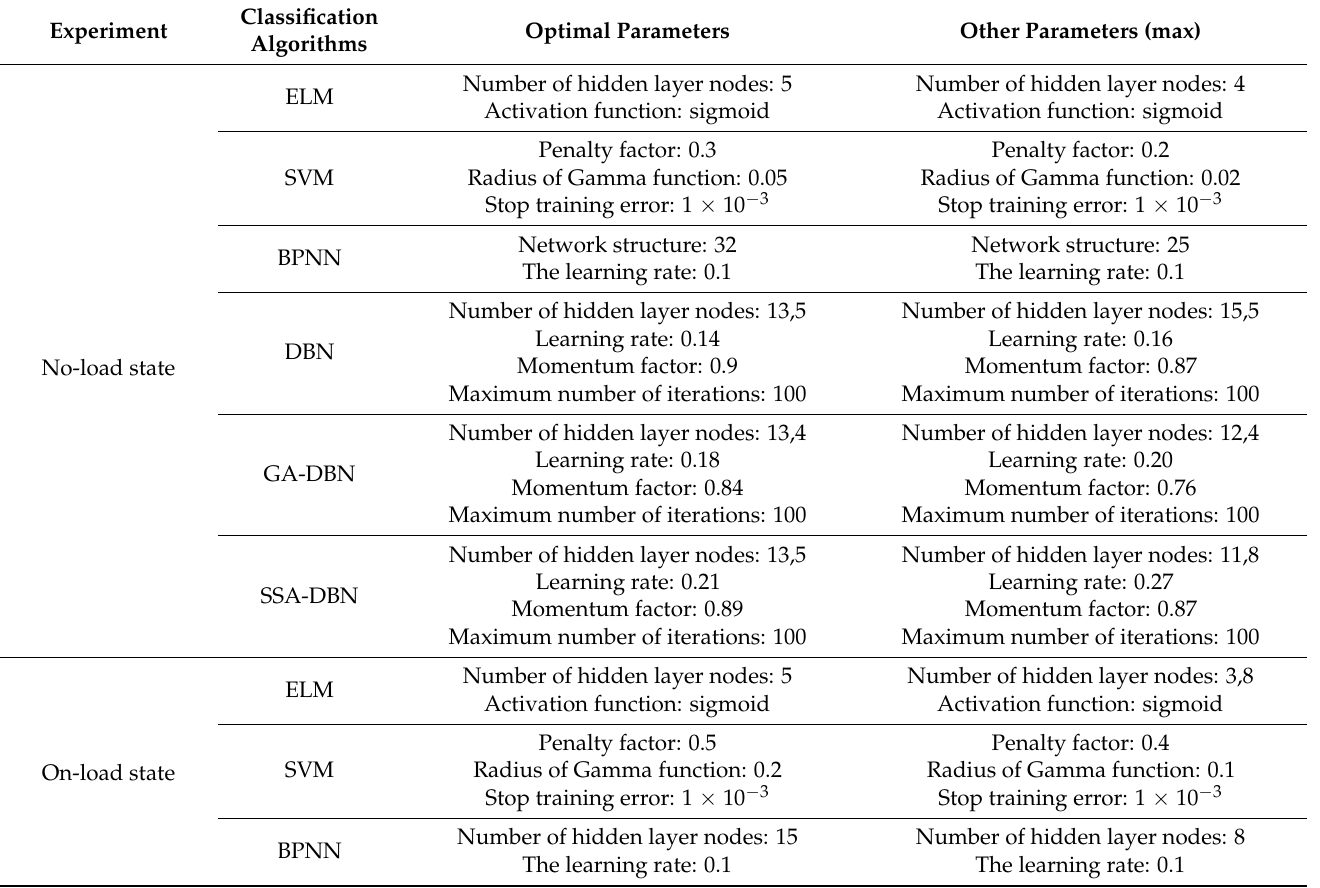
Table A1. Algorithm parameter settings of the